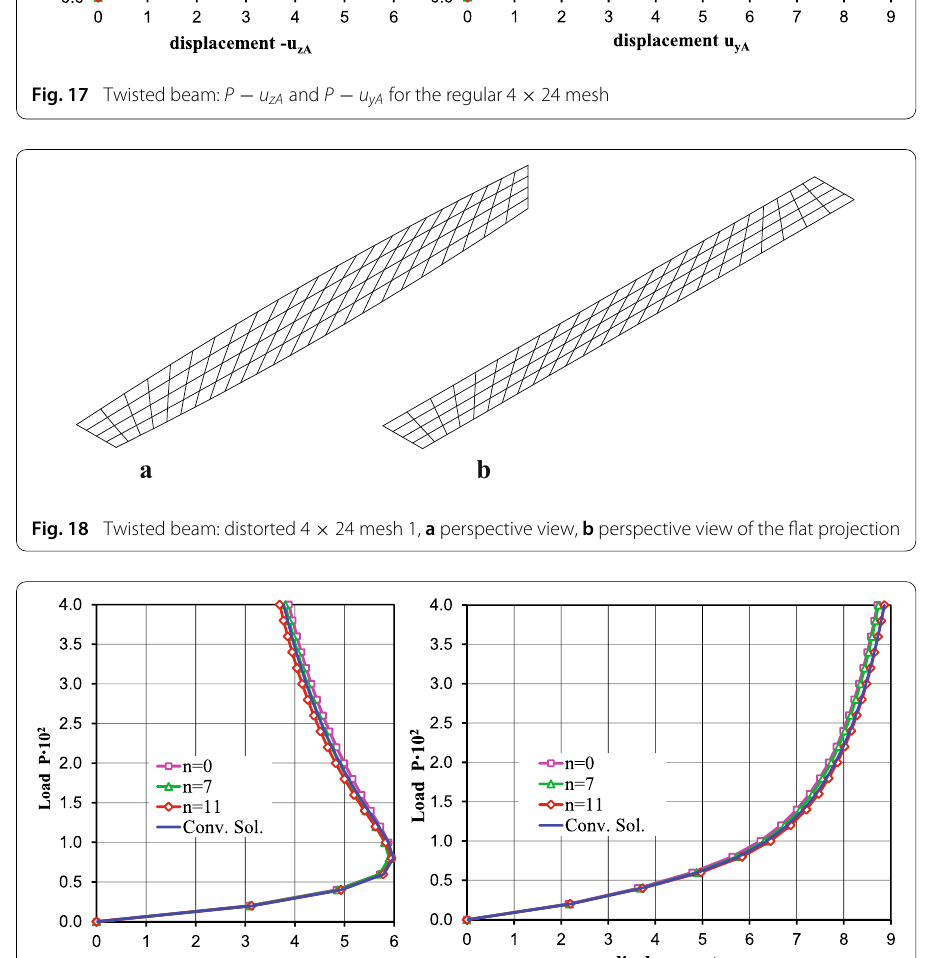
Fig. 19 Twisted beam: P − u zA and P − u yA for the distorted 4 × 24 mesh